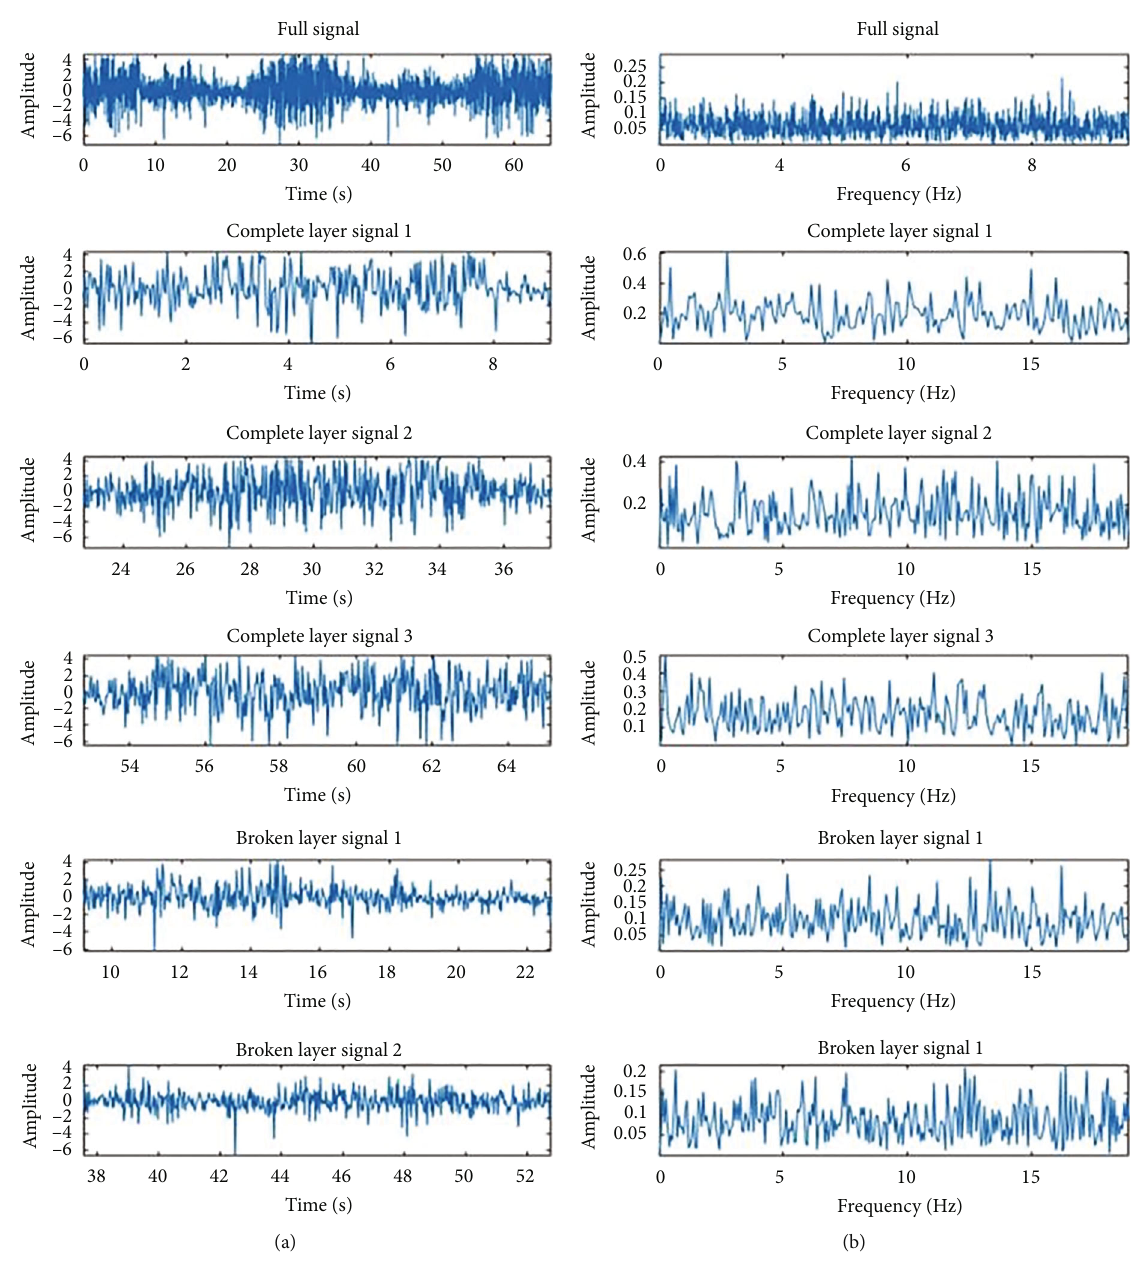
Figure 5: Time domain diagram (a) and frequency domain diagram (b) of the vibration signal from borehole